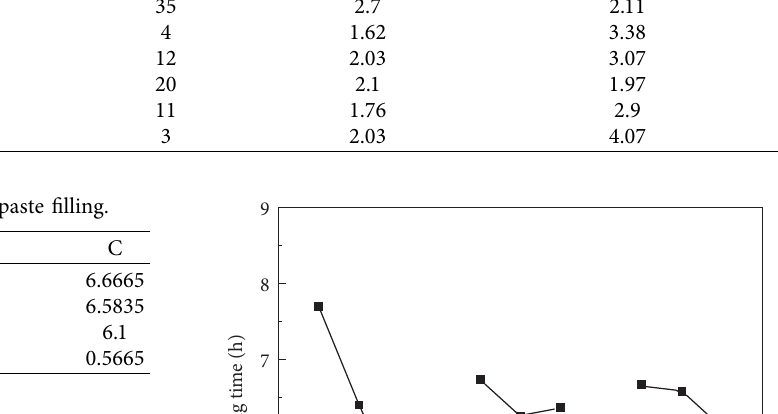
Table 5: Results of the collapsed slump ( D A